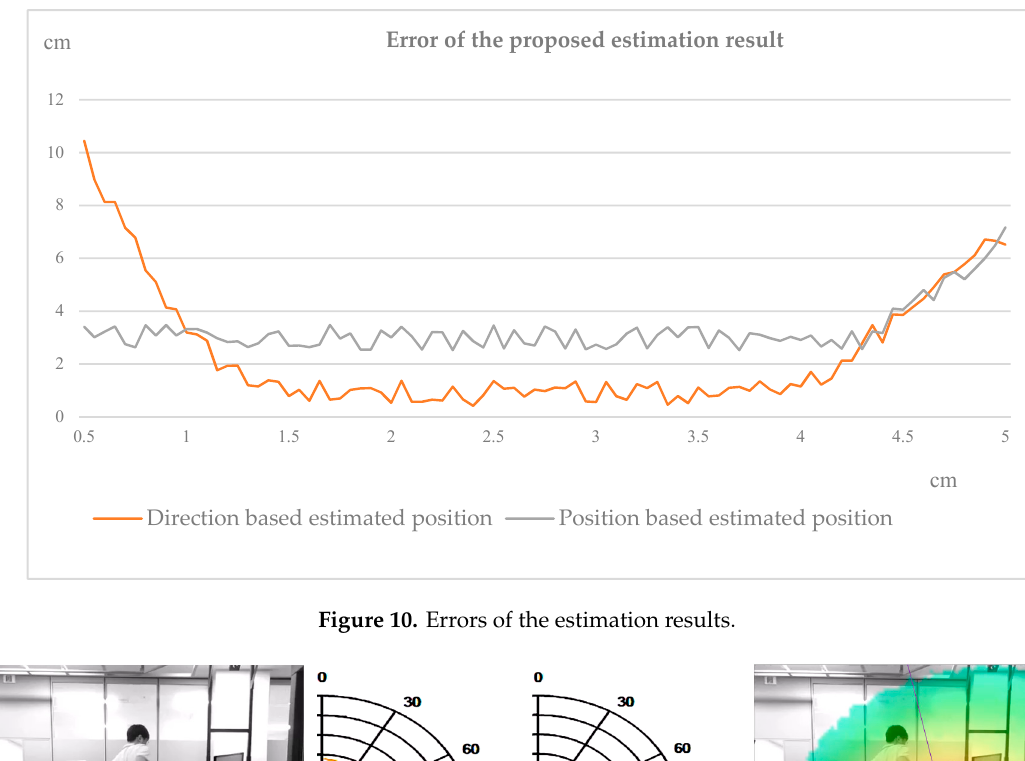
Figure 10. Errors of the estimation results.